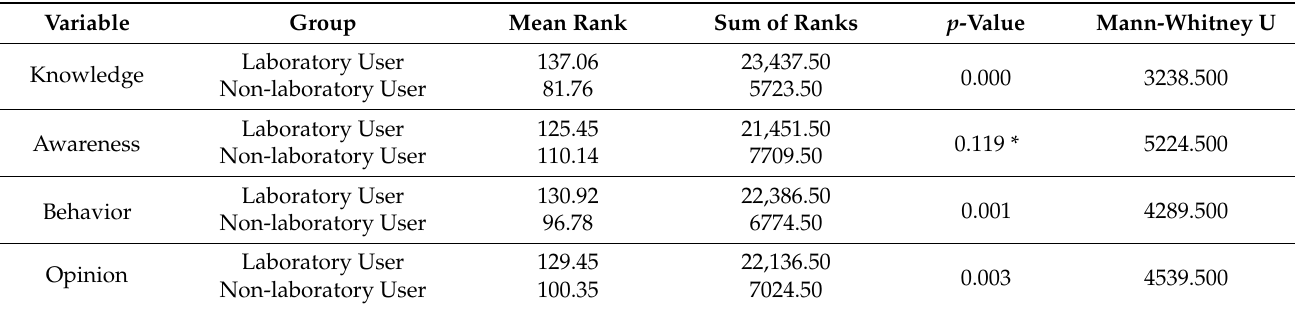
Table 5. Mann–Whitney U test in phase 1